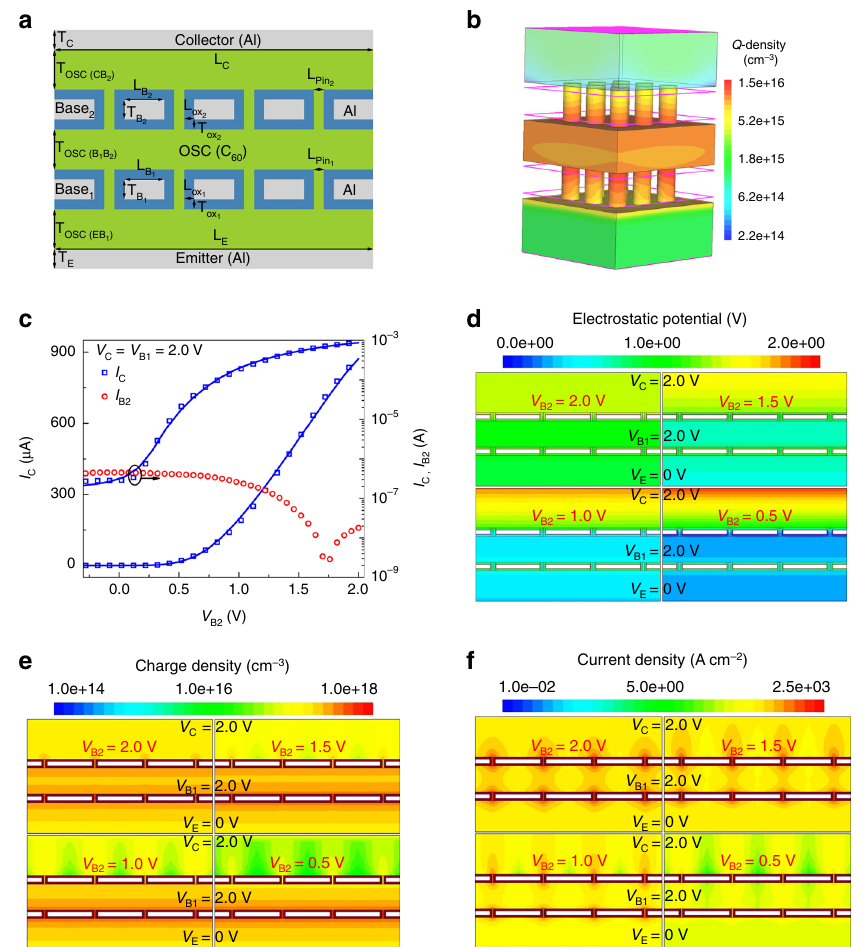
Fig. 4 TCAD simulation of OPDBTs. a Schematic cross-section of the simulated OPDBT used for Sentaurus TCAD setup. b 3D-OPDBT structure depicting simulated charge density of the same number of pinholes in base1 and base2 N Pin1 = N Pin2 = 9, with the emitter being bottom contact and collector the top contact at V B1 = V B2 = V C = 2.0 V. c Transfer characteristics: Collector current I C from experimental data (diamonds) compared with data from TCAD simulation (solid lines), including the negligible measured base2 leakage current I B2 (circles) at V B1 = V C = 2.0 V. d – f Electrostatic potential ( d ), charge carrier density ( e ), and current density ( f ) pro fi les of OPDBTs at V B1 = V C = 2.0 V and V B2 = 0.5, 1.0, 1.5, and 2.0 V, voltage of V CC = 2.0 V. The VTCs in Fig. 5c, e exhibit well high and low states which are the result of the steep transfer curves of the OPDBTs in the logics. From the dynamic characteristics of Fig. 5d, f, NAND gate and AND gate logic circuits can operate well as expected at 1 MHz.